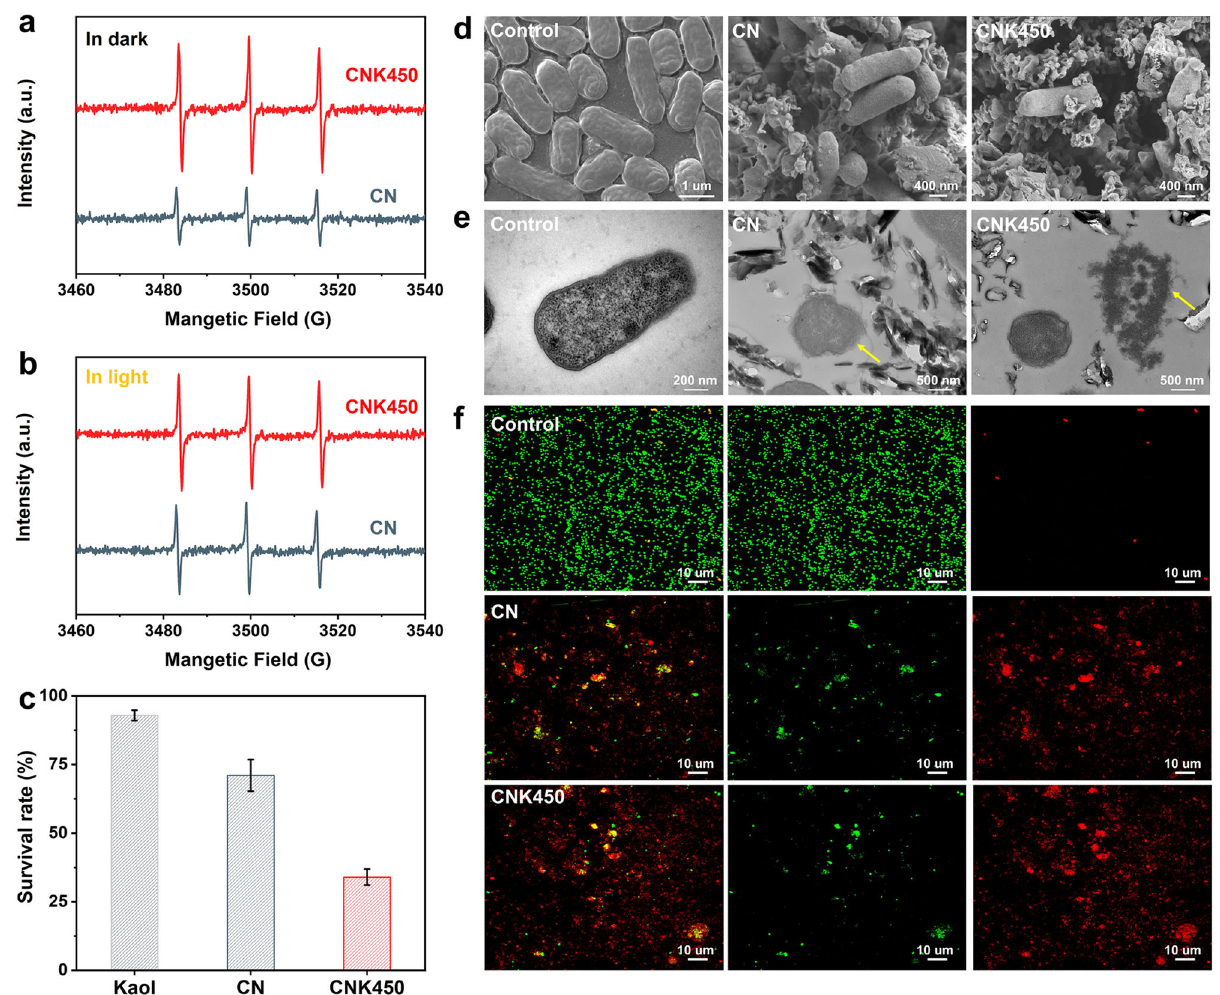
Fig. 4 Identi fi cation of singlet oxygen species and mechanism of disinfection mechanism. The EPR spectra of singlet oxygen species of CN and CNK450 a in the dark and b in the light. c Survival rate of E. coli . treated with samples in the light. d SEM images of E. coli . treated with CN and CNK450 samples under visible light. e TEM images of E. coli . treated with CN and CNK450 samples under visible light. (The yellow arrows indicate the deformed and wrinkled cell wall). f Confocal fl uorescent images of live and dead E. coli . control and treated with CN and CNK450